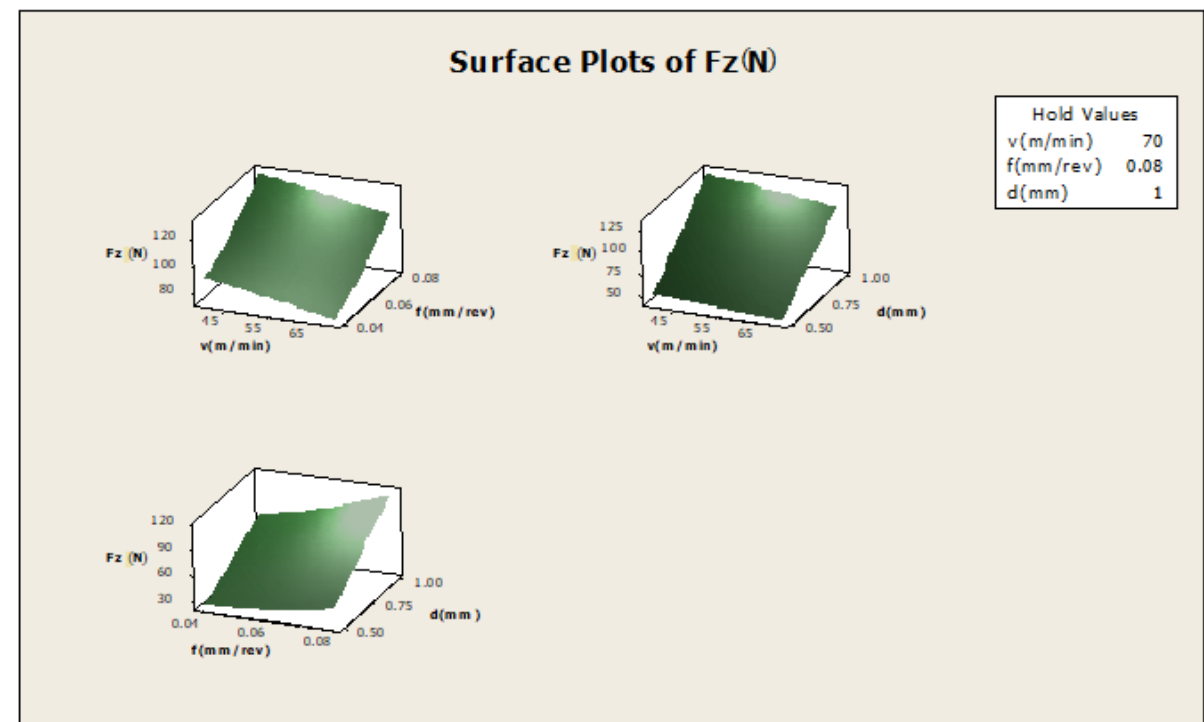
Figure 9. Surface plot for F Y .